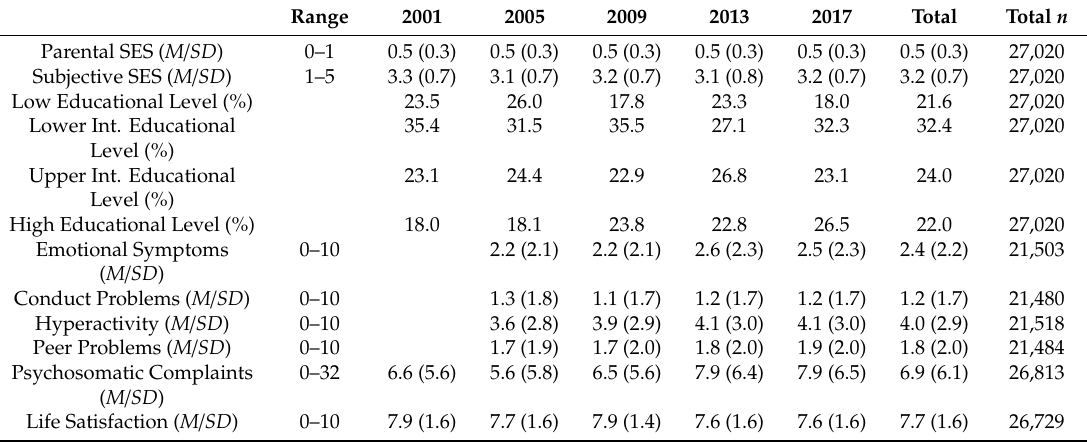
Table 1. Descriptive statistics for socioeconomic status (SES) and mental health problems by